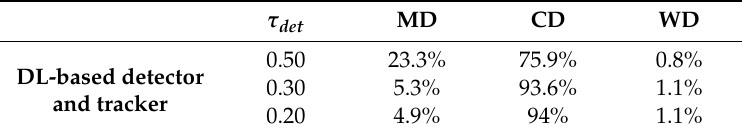
Table 10. DL-based detector and tracker performance as a function of τ det ( τ tr = 0.10). FT2-B composed of 735